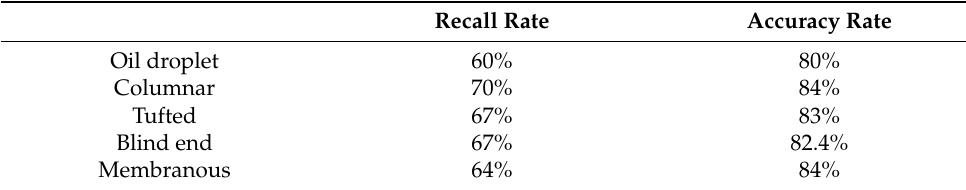
Table 2. Test result.